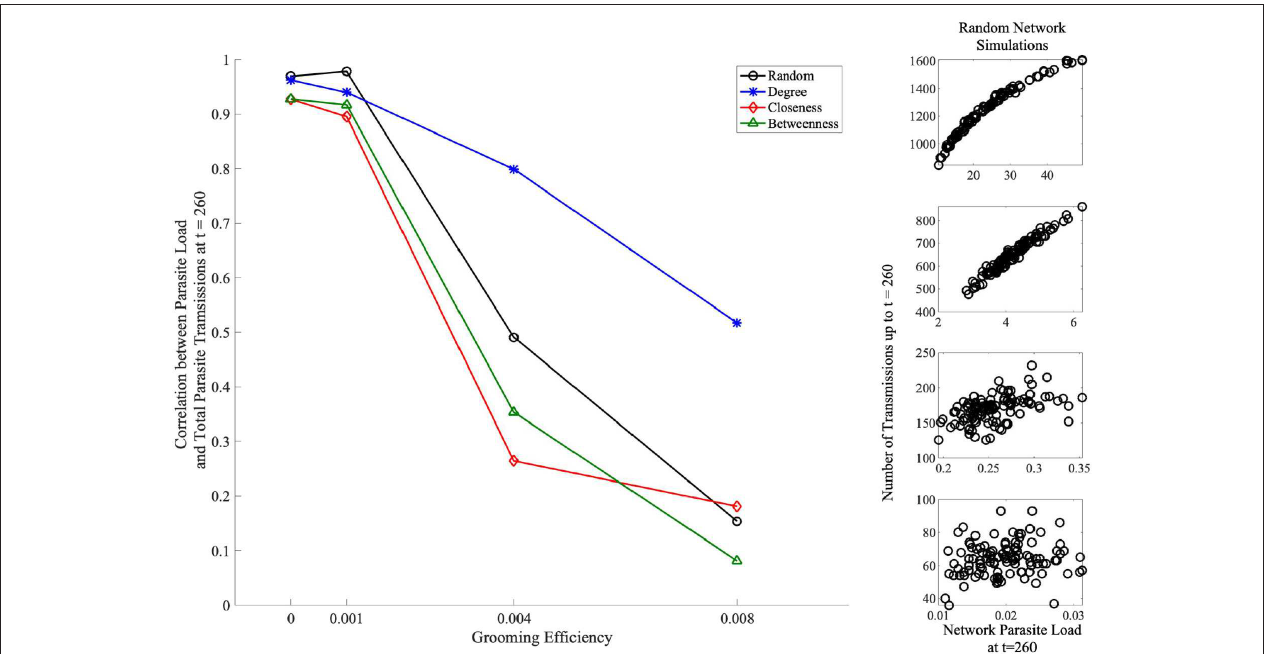
FIGURE 7 | Correlation between network ectoparasite load at t = 260 (110 time steps after ectoparasite introduction) and total ectoparasite transmissions across affiliation strategies and grooming efficiencies. The right column shows the ectoparasite load vs. number of transmission data points for the random affiliation strategy for each of the grooming efficiencies, organized from top to bottom: g = 0, g = 0.001, g = 0.004, and g = 0.008. Here, we see the high correlation between these quantities when g = 0 and conversely almost zero correlation between these quantities for g = 0.008. For networks organized with random, betweenness, and closeness affiliation strategies, this correlation is high for g = 0 and g = 0.001 and low for mid-to-high grooming efficiencies (black, green, and red markers/lines). In the network organized using a degree affiliation strategy (blue markers/lines), we see that the correlation remains high across all grooming